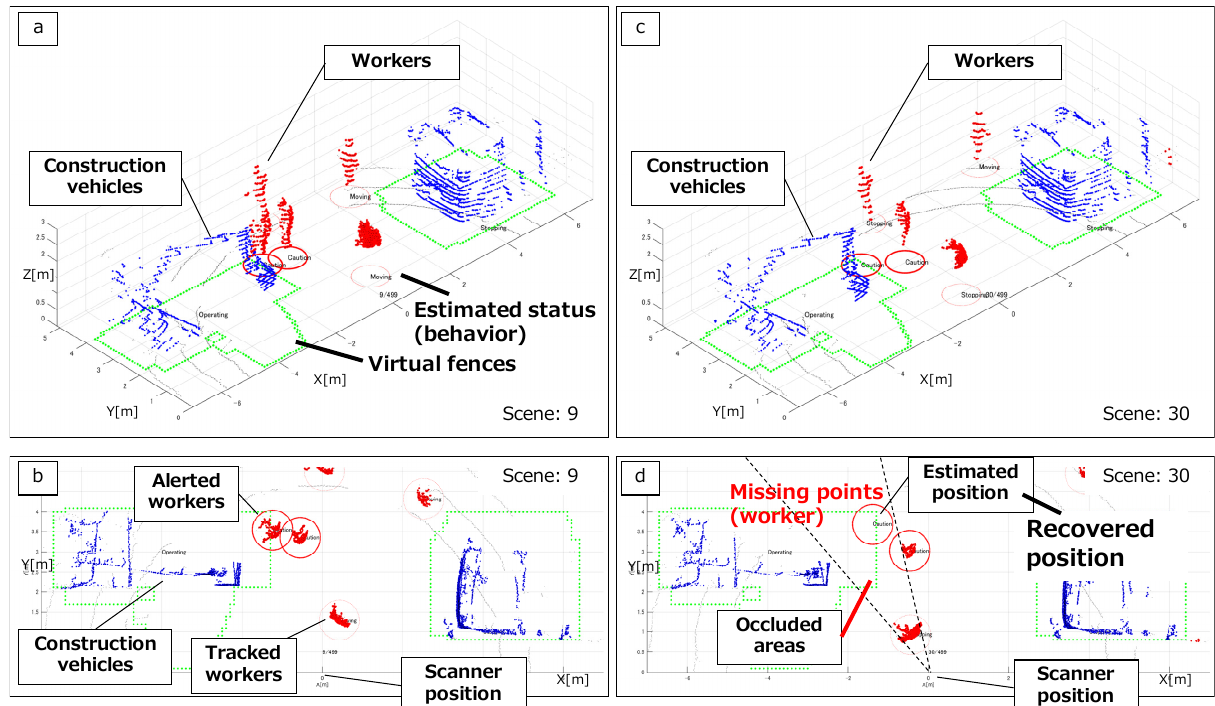
Figure 12. Object recognition result in a construction environment